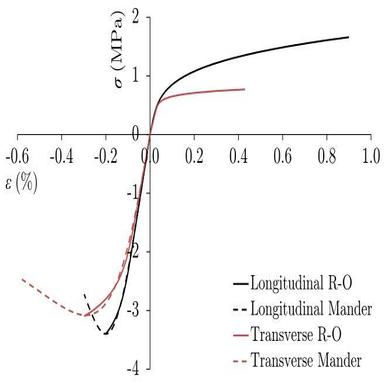
The Ramberg–Osgood (R–O) and Mander models using the average measured material properties of plasterboard, with positive values of stress and strain signifying tension (where only the R–O model is used) and negative values signifying compression (where both the R–O and Mander models are shown).